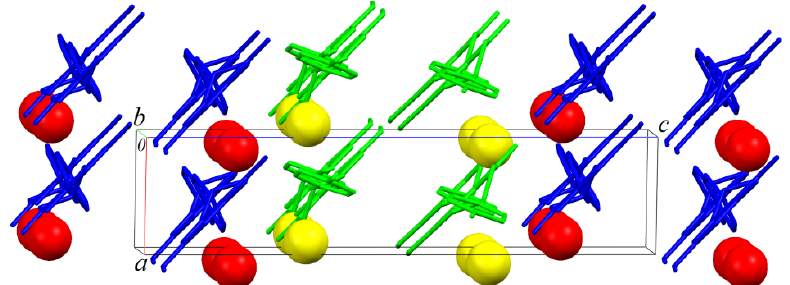
Figure 8. The crystal packing illustration of sakuranetin-monohydrate onto the ac plane.